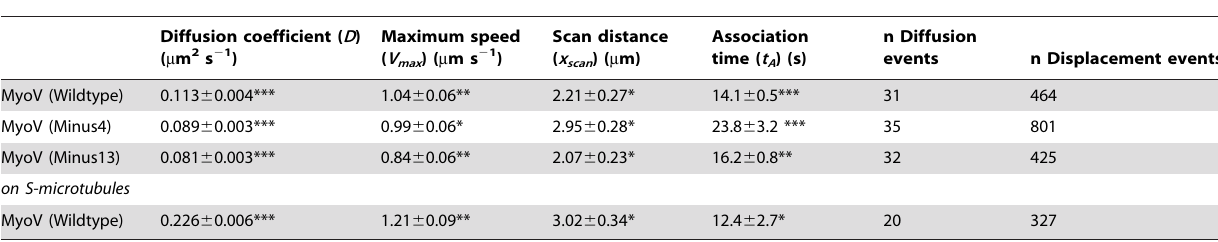
Table 1. Key parameters of diffusion of myosin V ( Wildtype ) and two myosin V loop 2